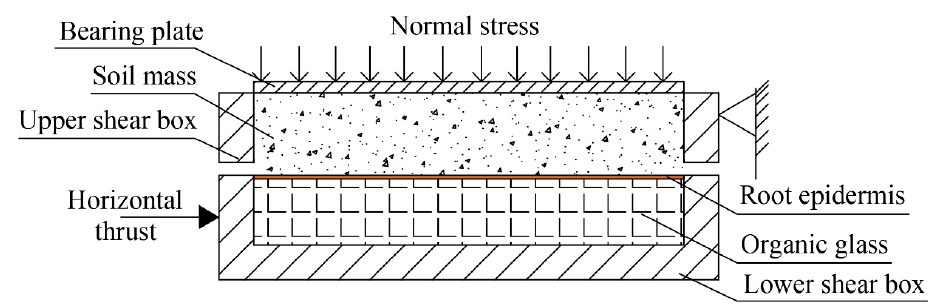
Figure 8. Quadruple strain control direct shear apparatus.